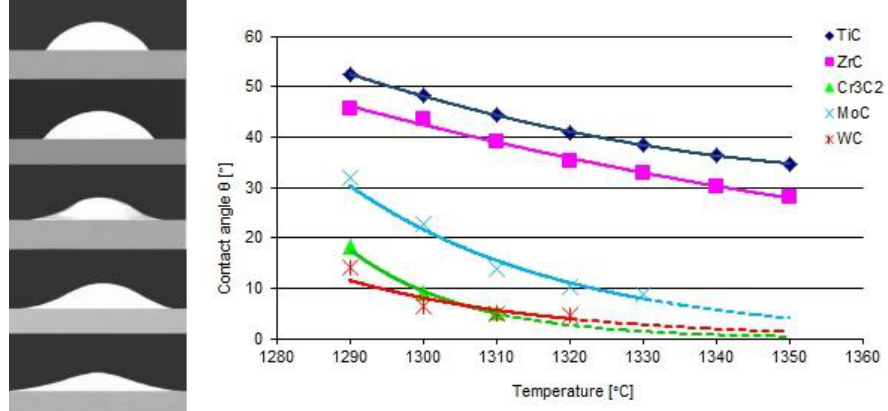
Figure 3. Wettability of carbides with a liquid NiBSi alloy: contours of droplets over flat TiC, ZrC, Cr 3 C 2 , Mo 2 C, and WC substrates at an initial temperature of 1290 ◦ C, and the temperature dependence of the contact angle (average of two trials). The broken line extrapolates the relationship after the completely spread of droplets ( θ ≈ 0 ◦ ).